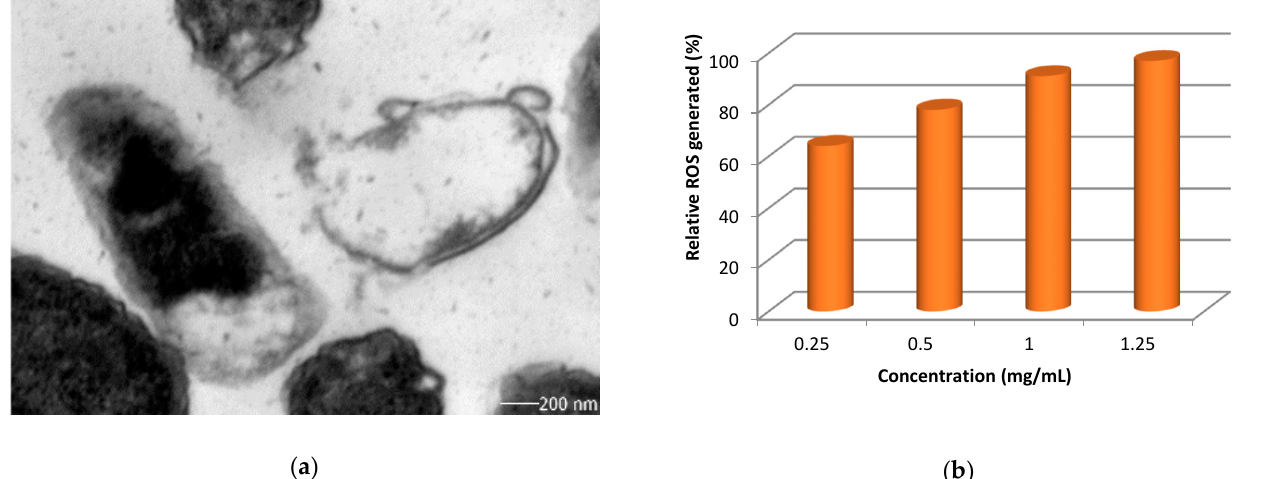
Figure 3. Mechanistic action of the prepared γ -Al 2 O 3 , analyzed using a TEM study ( a ) and relative ROS generation ( b